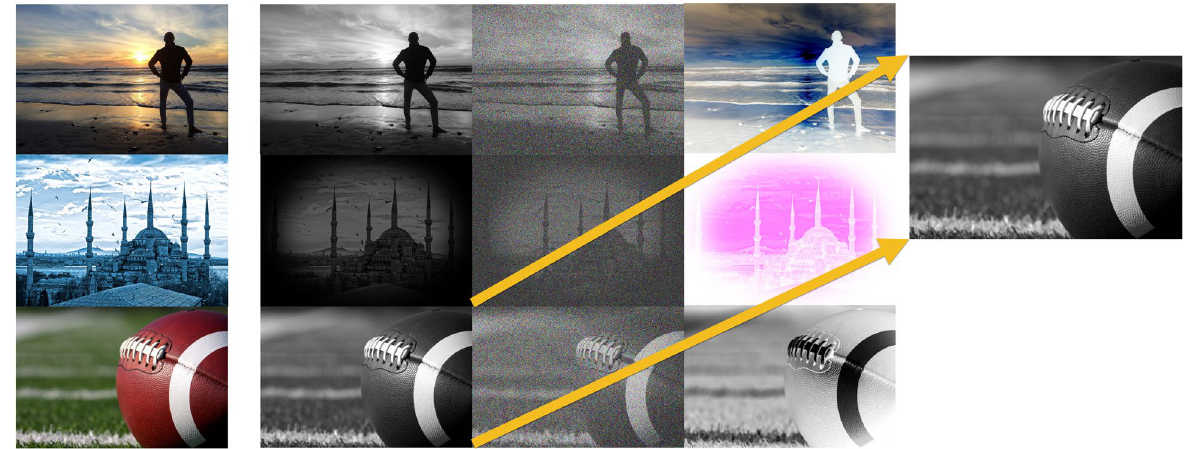
Fig. 12 An example that clarifies the resultant deformations output through the ‘Preparation